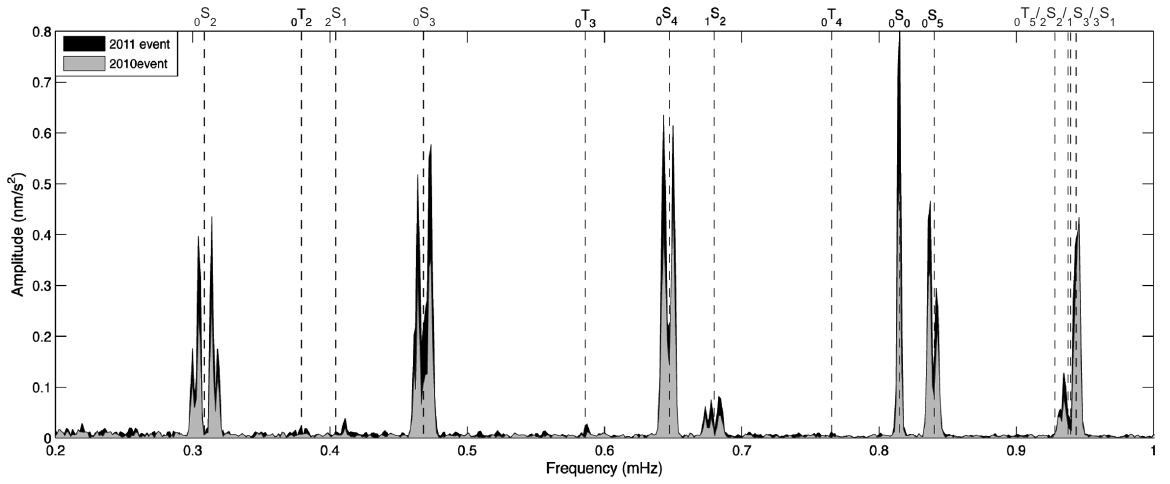
Figure 1. The amplitude spectra of the residual gravity sequences from CB station after the 2010 Maule event (gray area) and 2011 Tohoku event (black area), both of the sequences starting 5h after the earthquake with a length of